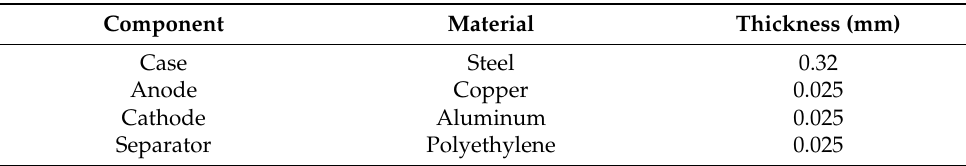
Table 1. Mechanically relevant battery